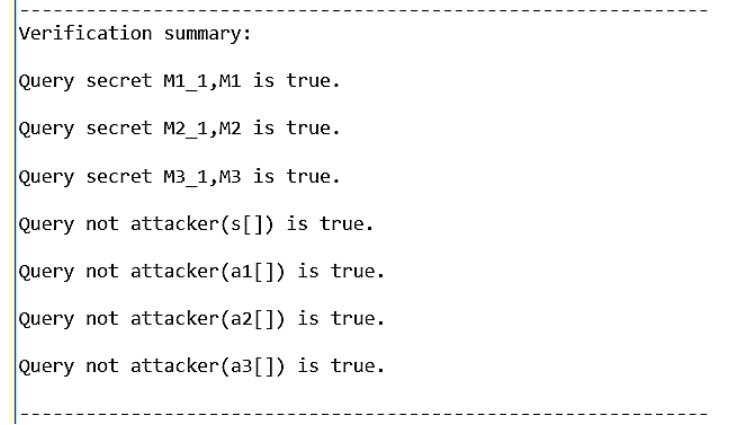
Figure 6. The code for the mutual authentication phase of our protocol.